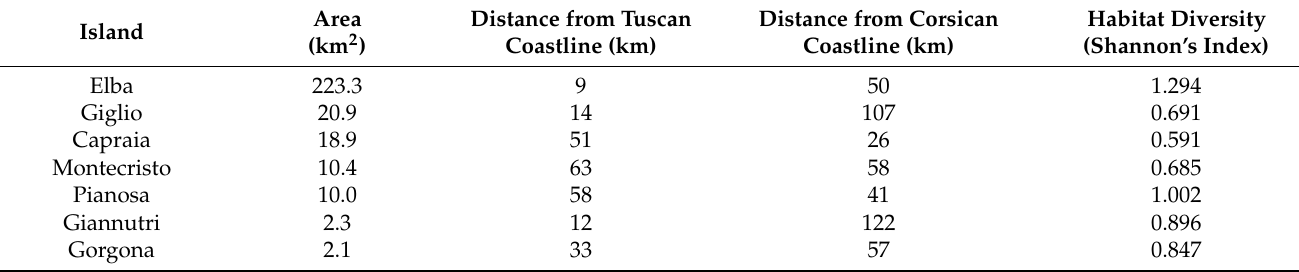
Table 2. Island covariates used in the analyses. The Shannon’s Index was calculated on the fractional cover of land-use types of the CORINE